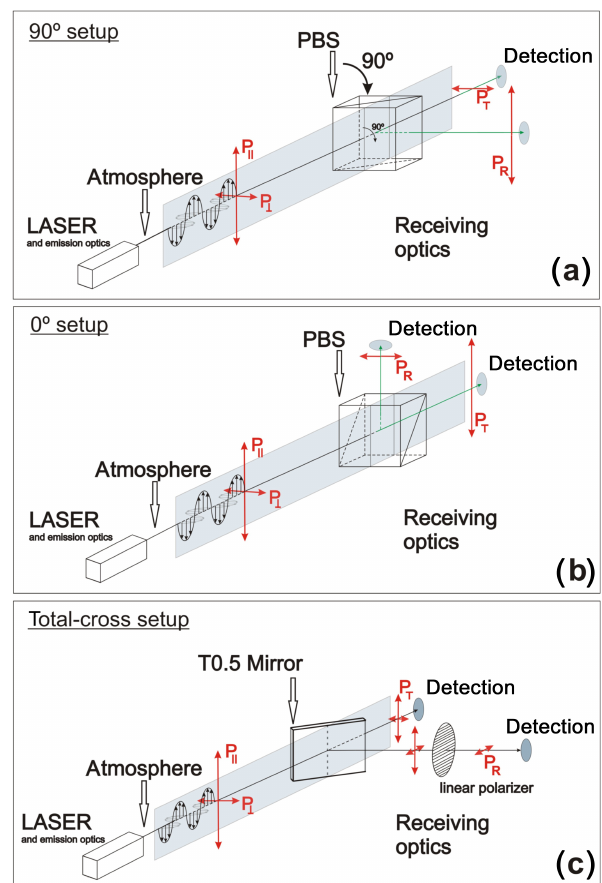
Figure 2. Detection setups (according to Freudenthaler et al., 2009). P ⊥ and P (cid:107) are the collected components (parallel and cross). P T and P R are detected components of the collected radiation (with contribution from the receiving optics). (a) 90 ◦ detection setup, (b) 0 ◦ detection setup and (c) detection setup for PollyXT-type lidar systems. PBS is a polarizing beam splitter, T0.5 mirror is a 0.5 trans- mittance reflecting